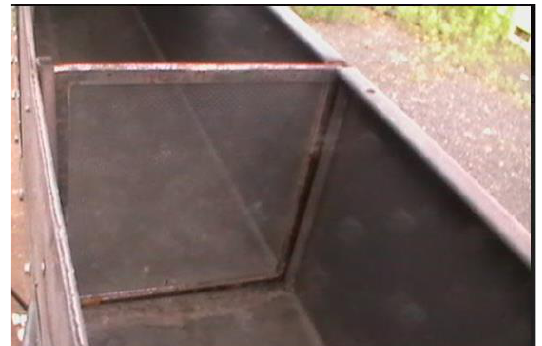
Figure 4. The mesh and mesh frame inside the